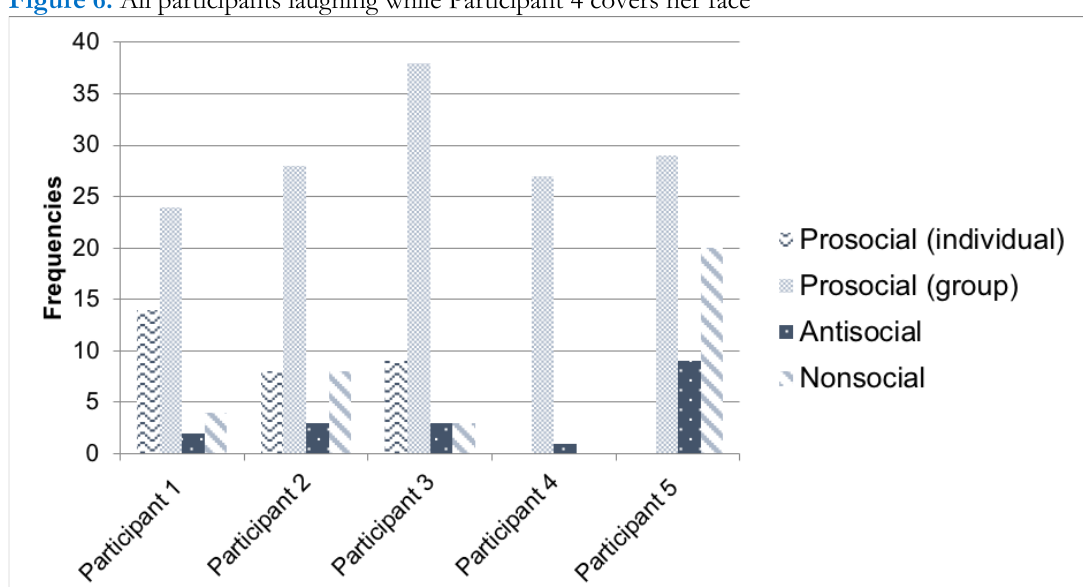
Figure 7. Participant (1-5) social behaviour counts with